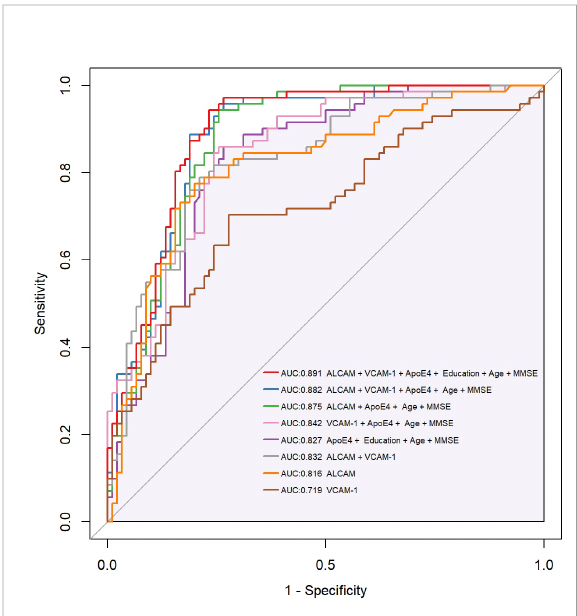
FIGURE 6 Compound ROC curve of all types of models. CAMs